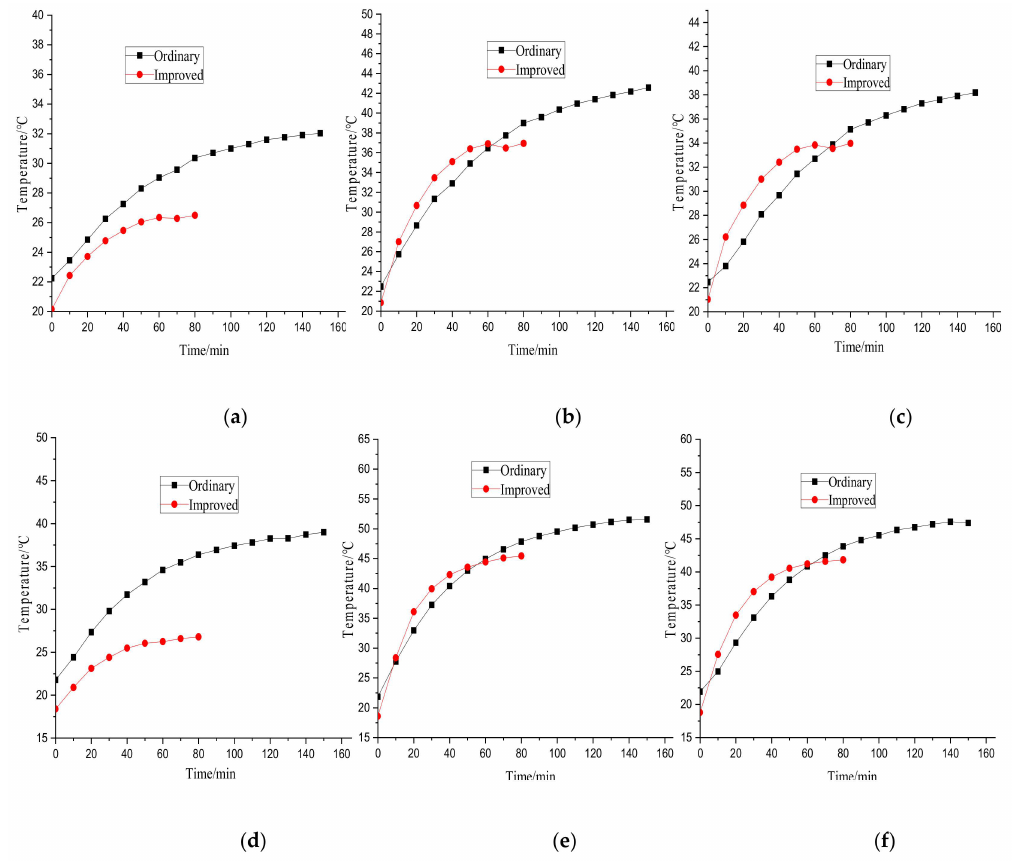
Figure 19. Temperature rise under di ff erent supply voltages. ( a ) Sensor 1, 20 V; ( b ) Sensor 2, 20 V;